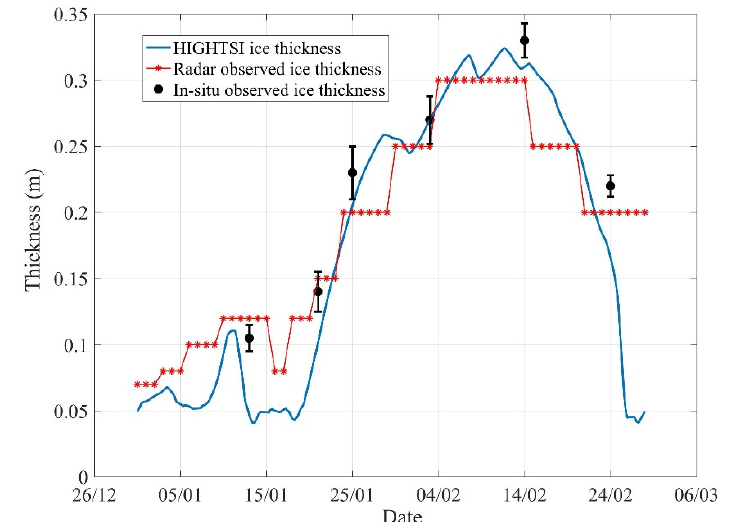
Figure 2. Seasonal evolution of modeled and observed ice thickness for 2017/2018 ice season. The vertical bar is the standard deviation of observed ice thickness.